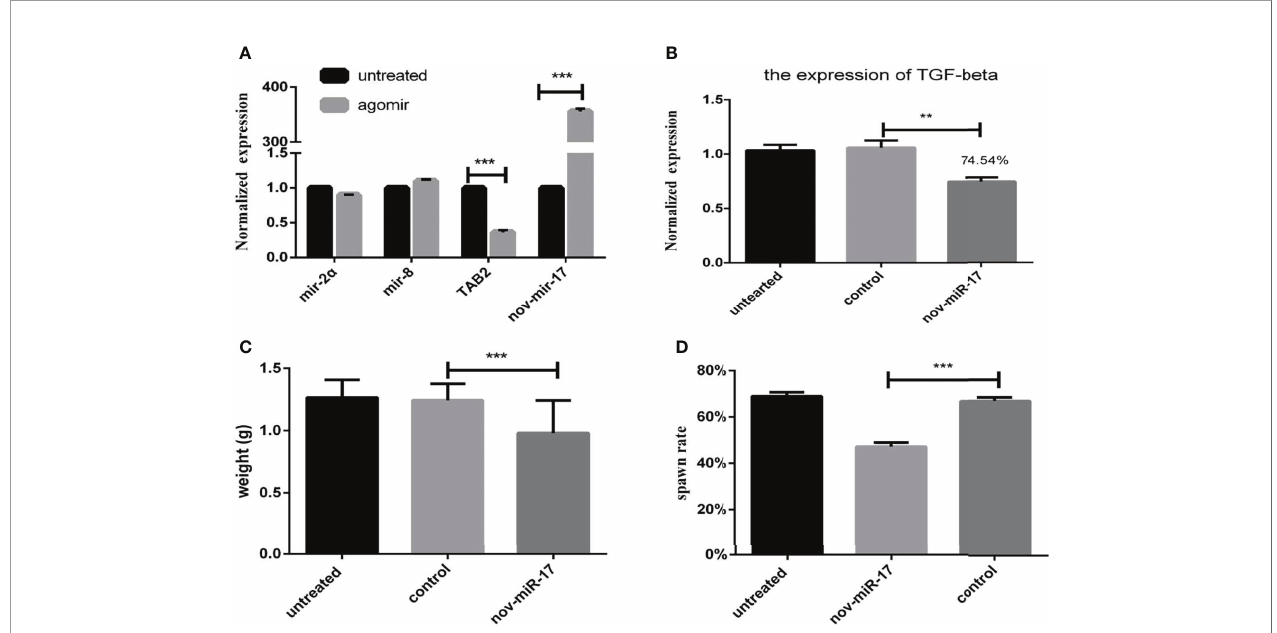
FIGURE 4 | (A) Expression of miR-2a, miR-8 and TAB2 24 h after injection of the agomir. (B) The weight of fed ticks was recorded after overexpression of nov-miR-17. (C) Number of days during which the ticks overexpress nov-miR-17. (D) Spawn rate of ticks overexpressing nov-miR-17. The data are presented as the means ± SEMs of triplicate samples. * P < 0.05, ** P < 0.01, *** P <